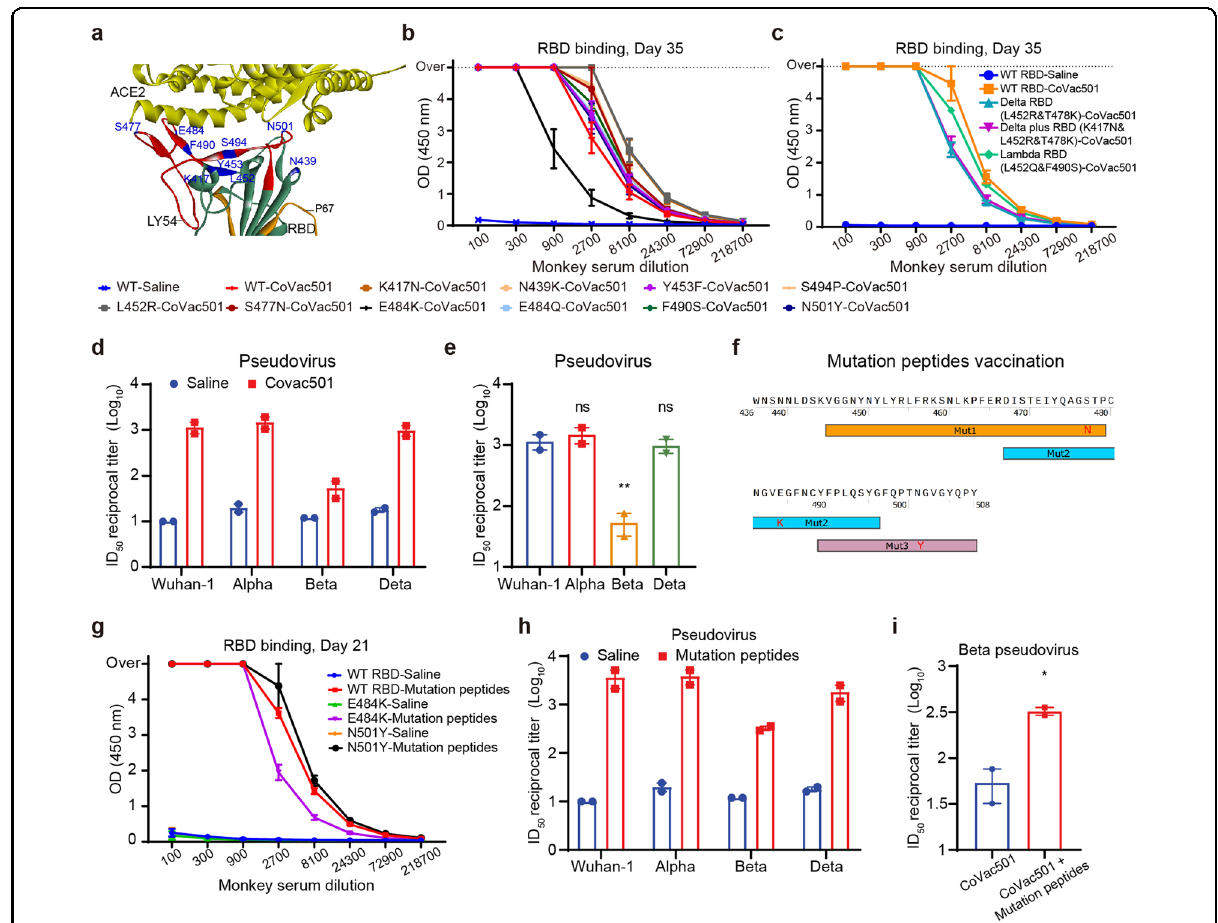
Fig. 7 CoVac501 induced humoral immune responses against SARS-CoV-2 variants. a Positioning of K417N, N439K, L452R, Y453F, S477N, E484K, E484Q, F490S, S494P, and N501Y in RBD. b , c Cynomolgus monkeys ( n = 2) were immunized with saline or CoVac501 for three doses at days 0, 14, and 28. Sera were collected from the monkeys 35 days after the fi rst dose of vaccine and the levels of RBD single mutations ( b ) and combined mutations ( c ) binding antibodies were tested for different serum dilutions using ELISA. d , e The neutralization of sera from cynomolgus monkeys 63 days after the fi rst dose of vaccine for SARS-CoV-2 original strain and variants (Alpha, Beta, and Delta) by the pseudovirus test. ID 50 reciprocal titers were compared to the saline group ( d ) or between variants ( e ). f The graph shows the amino acid sequences of mutation peptides. g Cynomolgus monkeys ( n = 2) were immunized with saline or mutation peptides for two doses at days 0 and 14. Sera were collected from the monkeys 21 days after the fi rst dose of vaccine and the levels of RBD mutations (E484K and N501Y) binding antibodies were tested for different serum dilutions using ELISA. h , i The neutralization of sera from cynomolgus monkeys 21 days after the fi rst dose of mutation peptides for SARS-CoV-2 original strain and variants (Alpha, Beta, and Delta) by the pseudovirus test. ID 50 reciprocal titers were compared to the saline group ( h ) or to the CoVac501 group for Beta pseudovirus ( i ). ** P < 0.01; * P < 0.05; ns, not signi fi cant as determined by unpaired t- test. All data are presented as the means ±